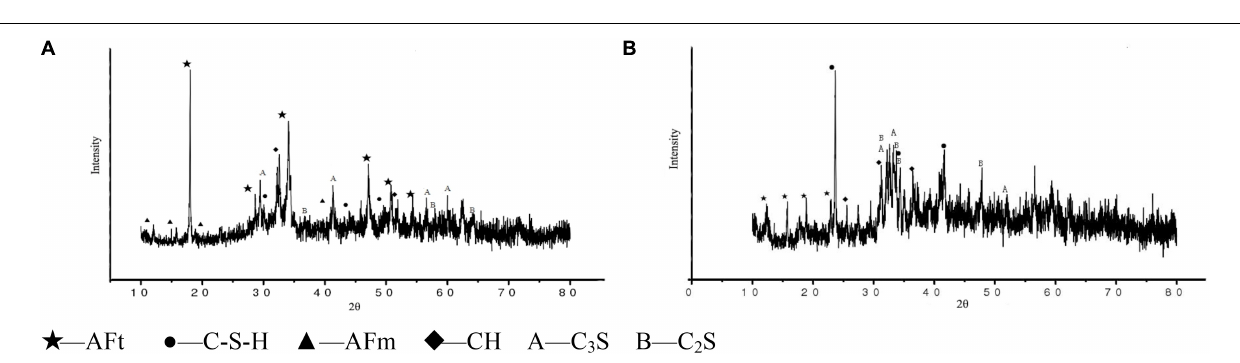
FIGURE 7 | (A) Hydration products of CAEM at 2 h. (B) Hydration products of CAEM at 28